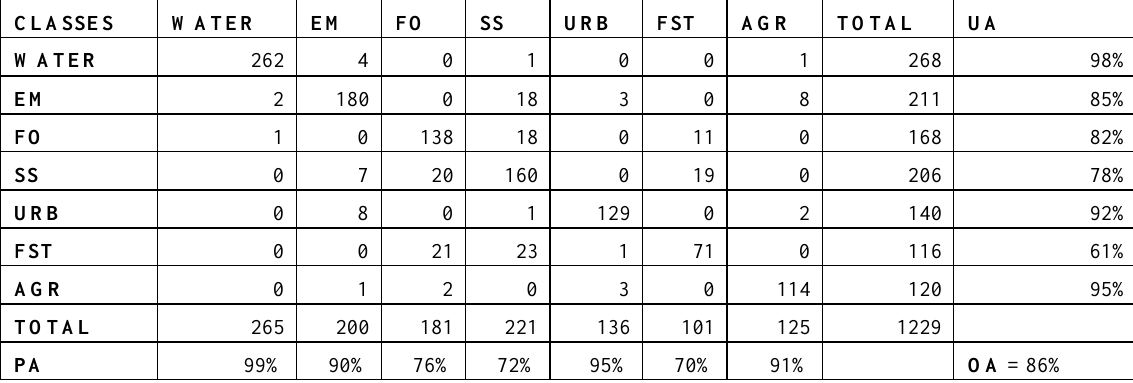
Table 2. Classification error matrix for random forest classifier using only Sentinel-2 optical imagery. Key: EM- Emergent wetland, FO-Forested wetland, SS-Scrub-Shrub wetland, URB- Urban, FST- Forest, AGR-Agriculture, UA- User accuracy,